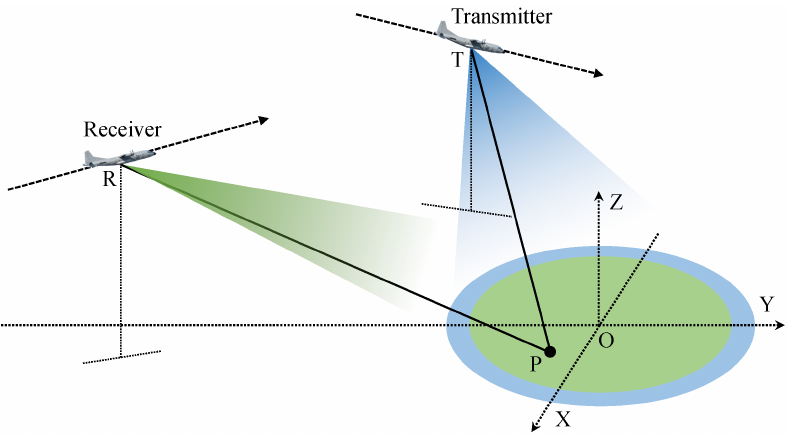
Figure 1. General BiSAR